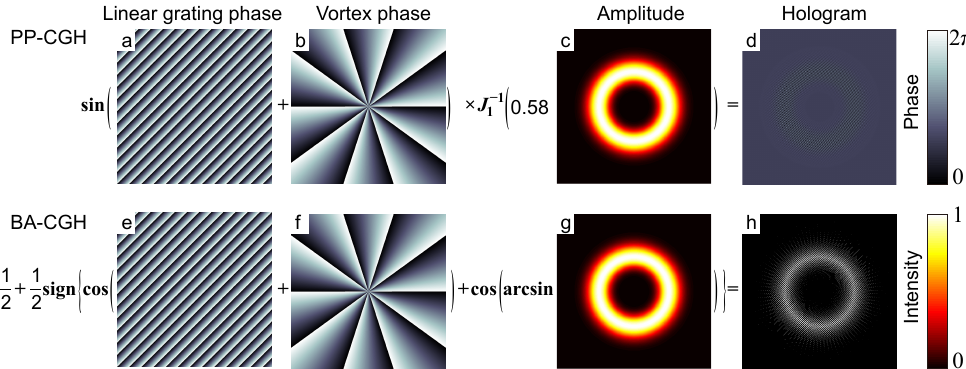
Figure 2. An example of constructing CGH hologram, ( a – d ) are construction method for PP-CGH (where J − 1 is inverse of 1 st Bessel function), ( e – h ) are construction method for BA-CGH and ( d , h ) 1 are phase gray hologram and binary amplitude hologram of LG 10